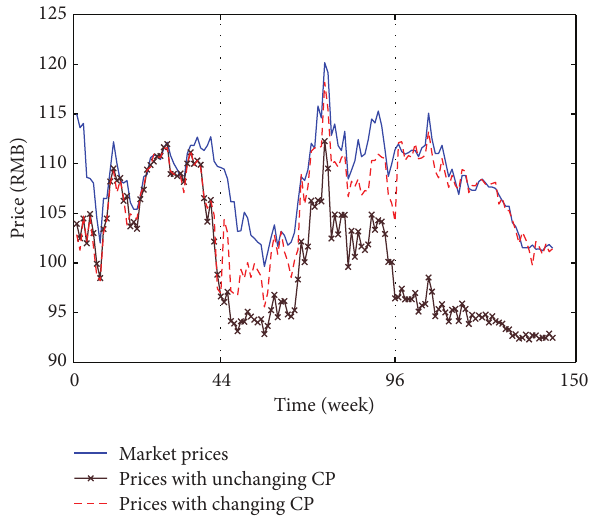
prices of ICBC convertible bond assuming that the conver- sion price does not change. The pricing results together with those obtained from changing conversion price are shown in Figure